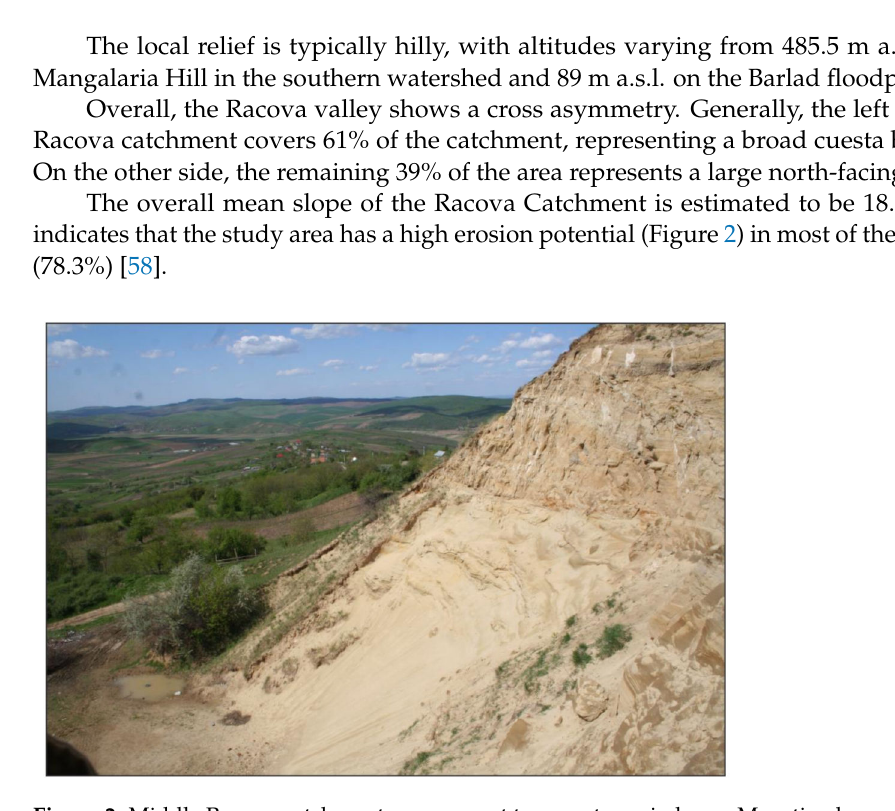
Figure 2. Middle Racova catchment as seen next to an outcrop in lower Maeotian layers at 350 m on Poienesti Hill, towards Magura Hill (444 m) in the